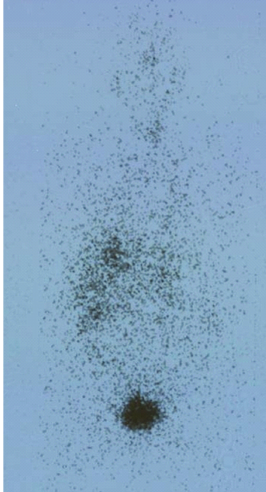
Figure 2: 131 I-MIBG scan showing increased uptake in the right suprarenal region, consistent with adrenal